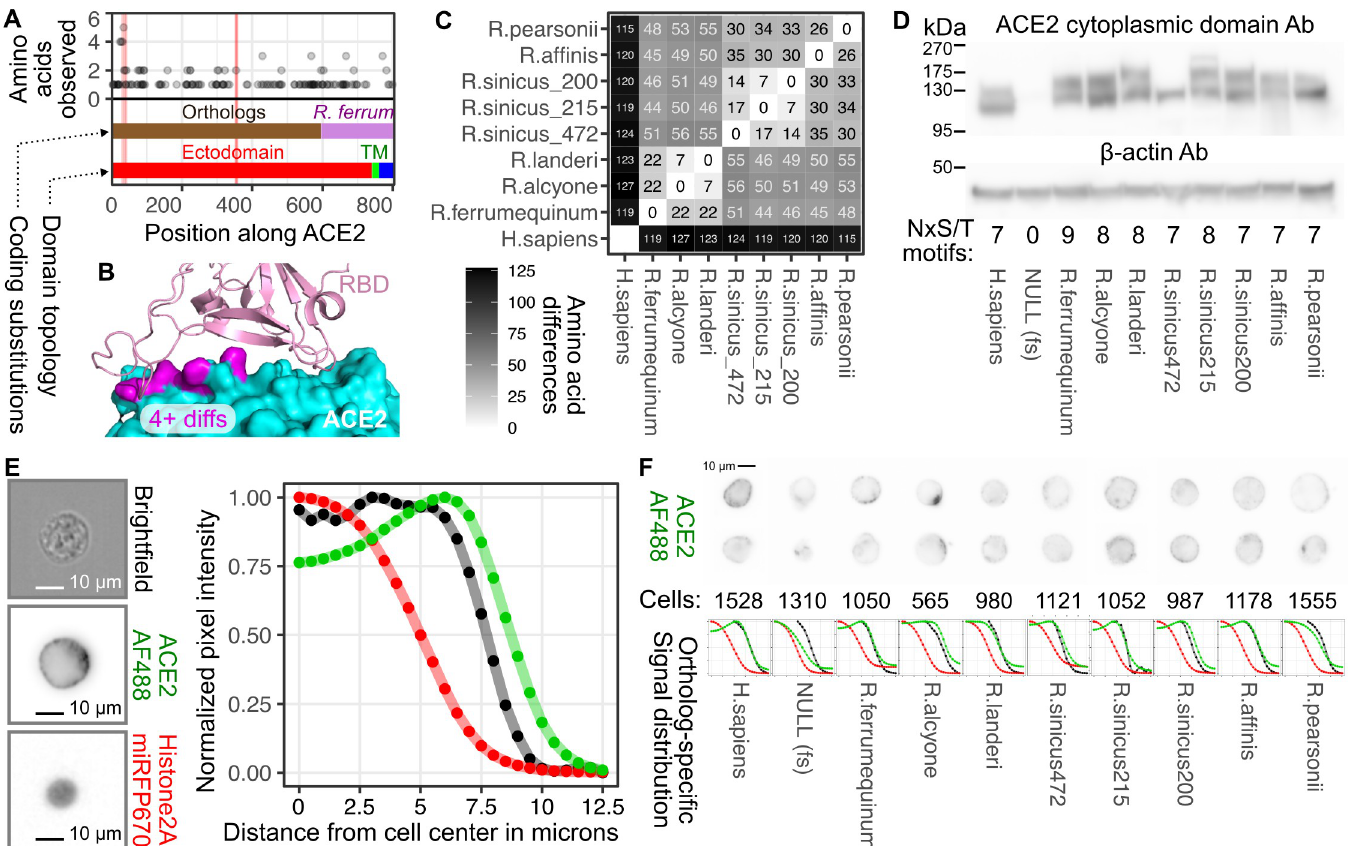
range of the microscopy assay, the results between the 2 measurements were largely consistent